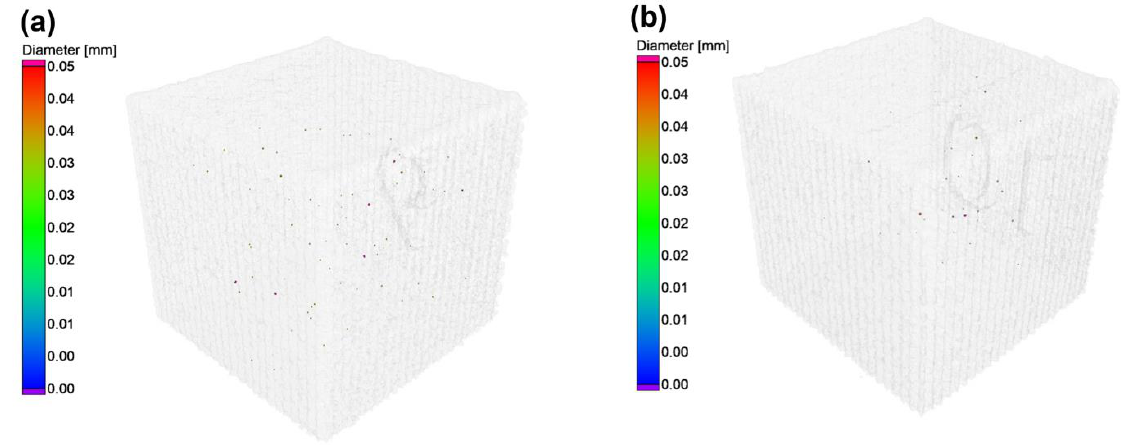
Figure 11. XCT porosity analysis from the predicted optimum parameter sets in Table 4.